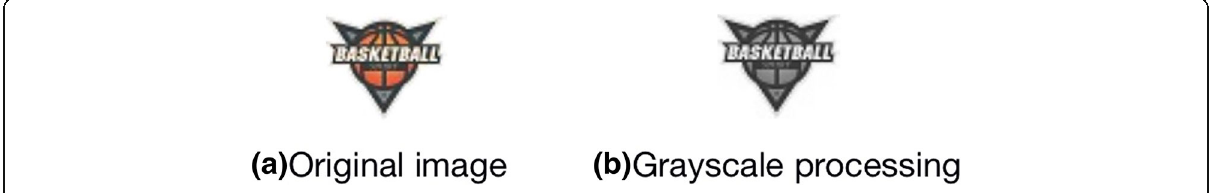
Fig. 2 Logo image grayscale. a Original image. b Grayscale